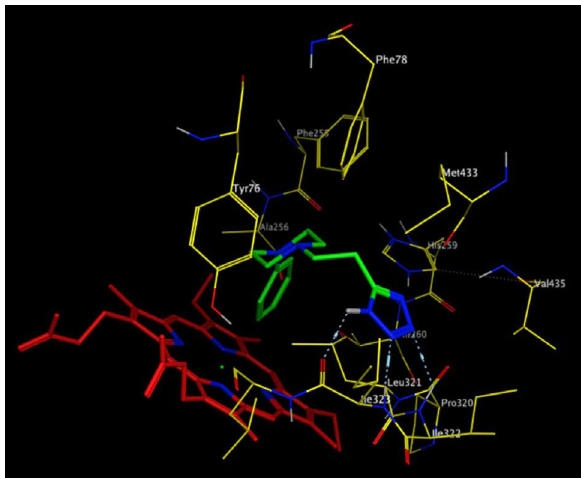
Figure 3. Docking conformation of 2n at the active site of Mycobac- terium